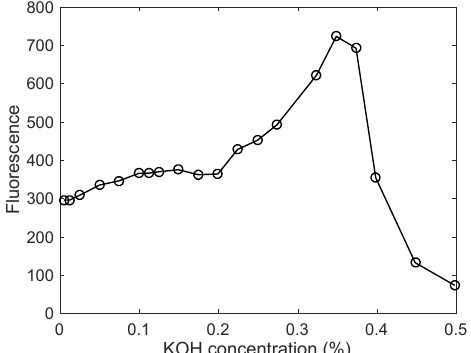
Figure 3. Sensitivity test for samples with 0.010gL − 1 NH + varying concentrations of KOH in reaction bottles. KOH clearly has an effect on fluorescence. Fluorescence values are consistent be- tween 0 and 0.2% KOH, with a large increase approaching 0 . 35% KOH and a steep drop-off at higher KOH concentrations. We sug- gest that high concentrations of KOH overwhelm the buffering ca- pacity of the working reagent and inhibit the completion of the flu- orescing reaction. All reported runs herein had between 0.05 and 0.2% KOH. Controlling KOH concentration is a key factor in the success of this